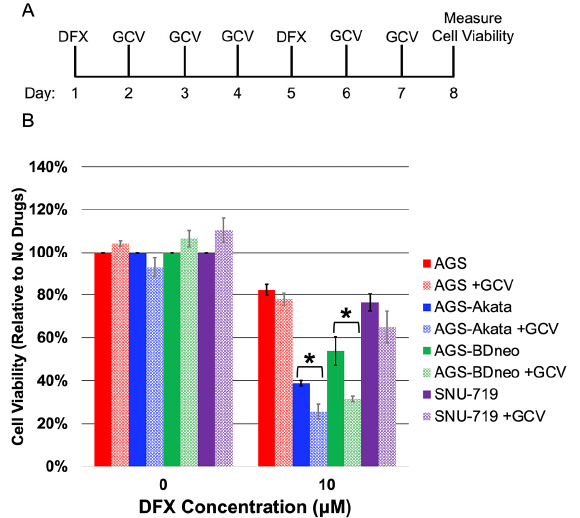
Figure 2. Ganciclovir enhances preferential killing of EBV-positive gastric cancer cells by DFX. ( A ) Schematic showing protocol used to examine effects of addition of GCV on killing by DFX. Cells were incubated for 24 h with 10 μ M DFX (or DMSO as the diluent control) on the 1st and 5th days of the experiment and 20 μ g/mL GCV (or the HCl diluent control) on each of the other days. Cell viability was determined on day 8. ( B ) Cell viability of EBV-negative AGS (red) cells and EBV-positive AGS-Akata (blue), AGS-BDneo (green), and SNU-719 (purple) after incubation with or without the indicated drugs as shown in panel A. Data for each cell line were normalized to the percentage cell viability observed when these cells were incubated in parallel with neither drug. Error bars represent ± S.E.M.; n = 3; *, p ≤ 0.05.